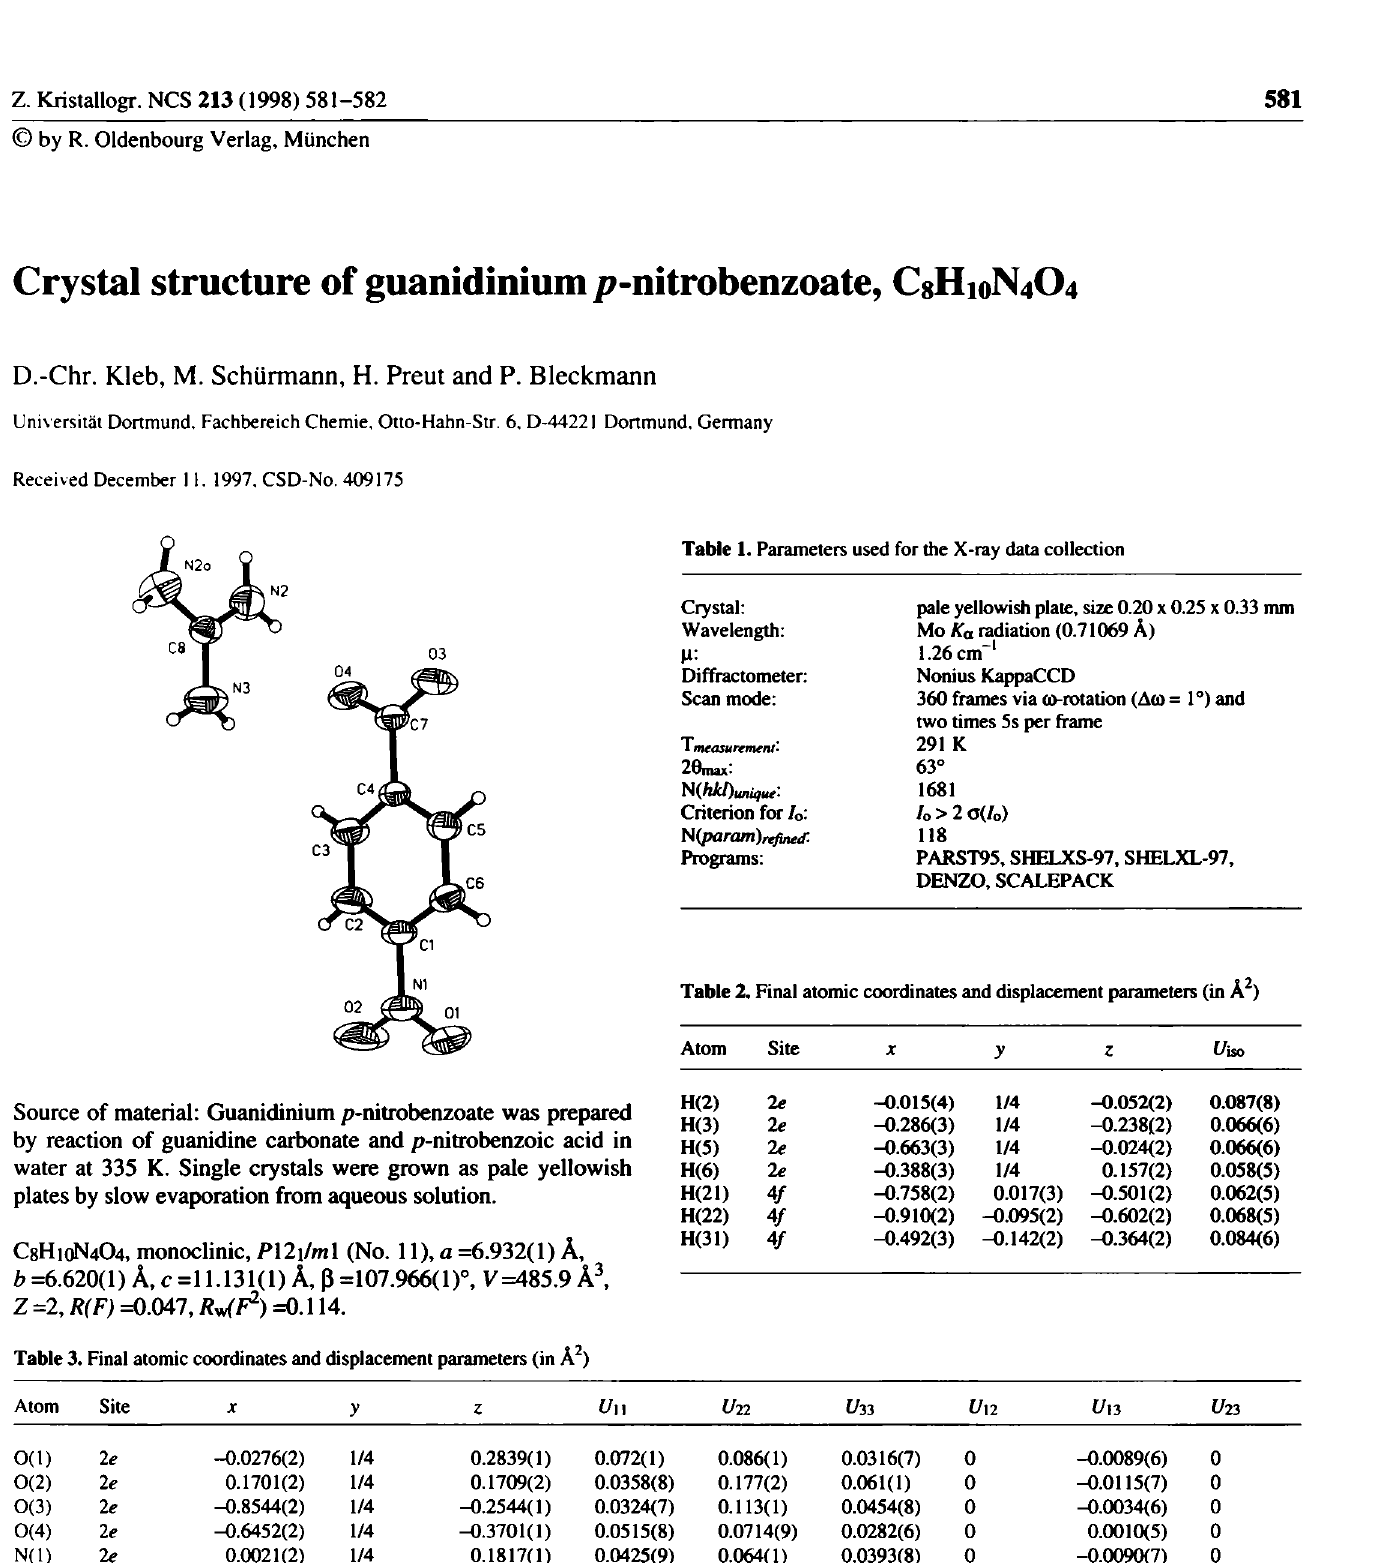
Table 3. Final atomic coordinates and displacement parameters (in Â^)